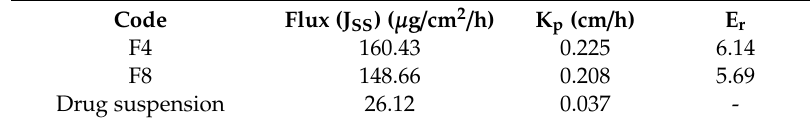
Table 2. Permeation data parameters.